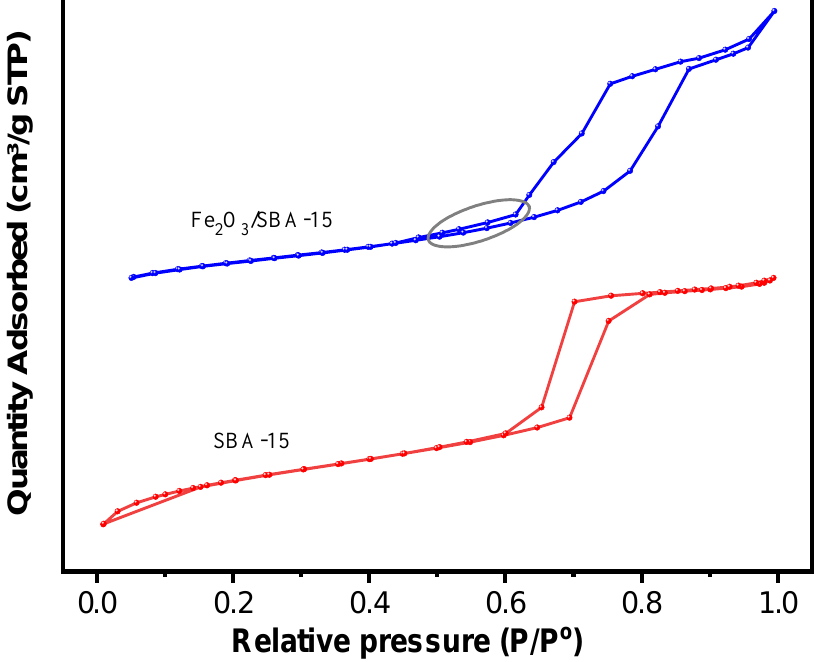
Figure 2. N 2 adsorption and desorption isotherms of SBA-15 and Fe 2 O 3 /SBA-15.